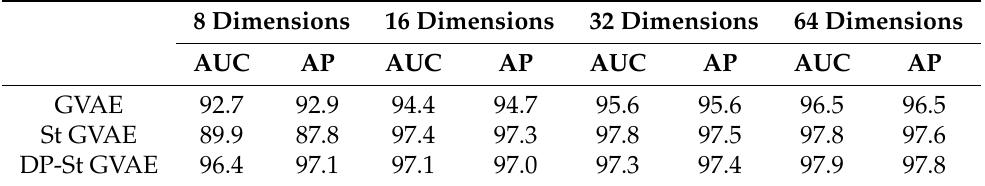
Table 4. Link prediction performance comparison of different dimensions for